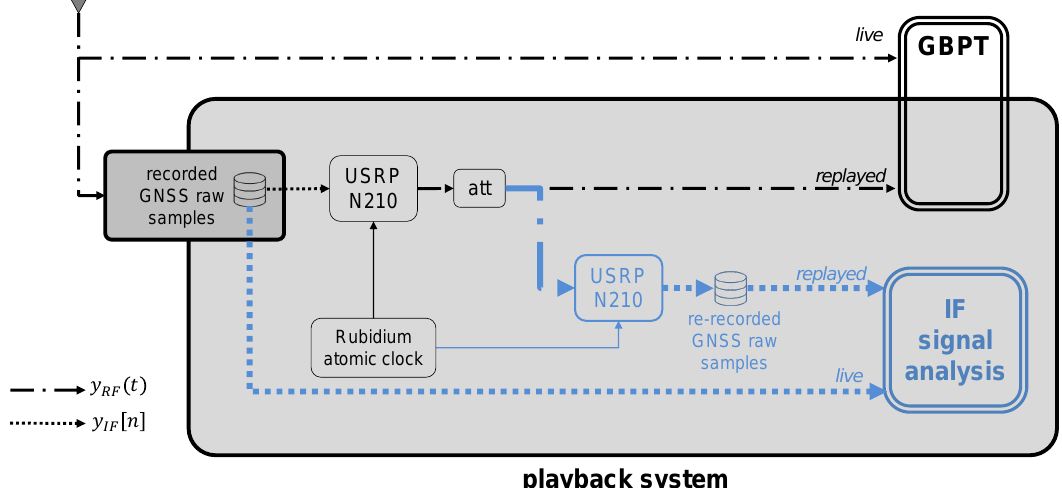
Figure 11. Test case for the urban environment. System